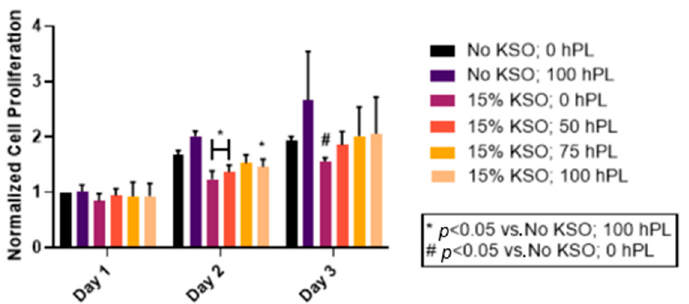
Figure 6. Cell proliferation of hDFs treated with hPL-loaded KSO hydrogels. hDFs were treated with hPL-loaded 15% KSO hydrogels, free-hPL (No KSO; 100 hPL), or left untreated (No KSO; 0 hPL). Cell proliferation was quantified at day 1, 2, and 3 with the CyQuant Cell Proliferation assay.